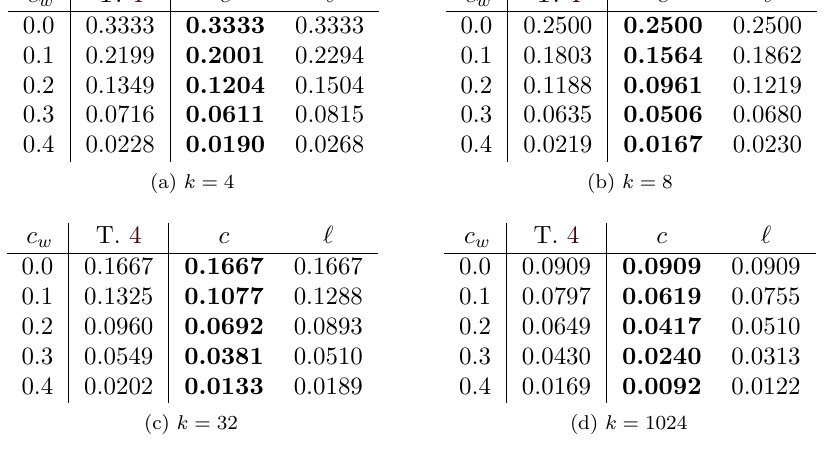
Figure 7: Parameters for different k , c w , compared to the run-time exponents log( T ) by Theorem 4 (last